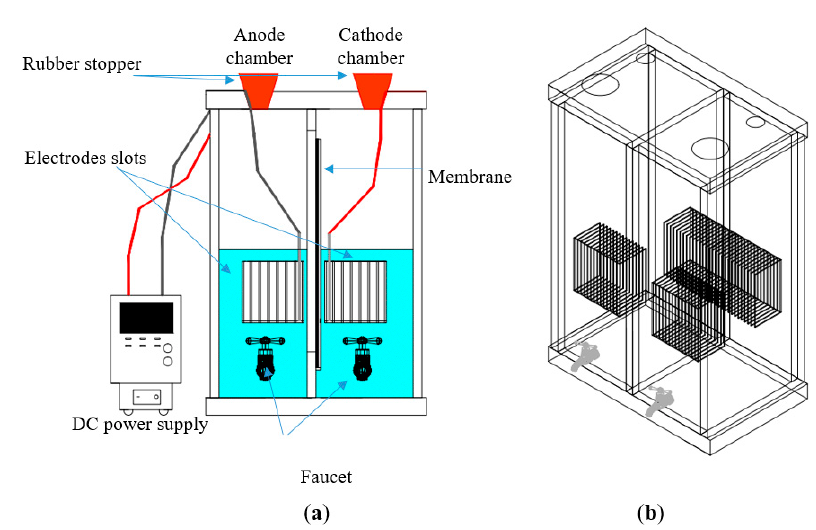
Figure 1. Schematic diagram of the laboratory-scale batch electrolysis unit: ( a ) front view and ( b ) side view.